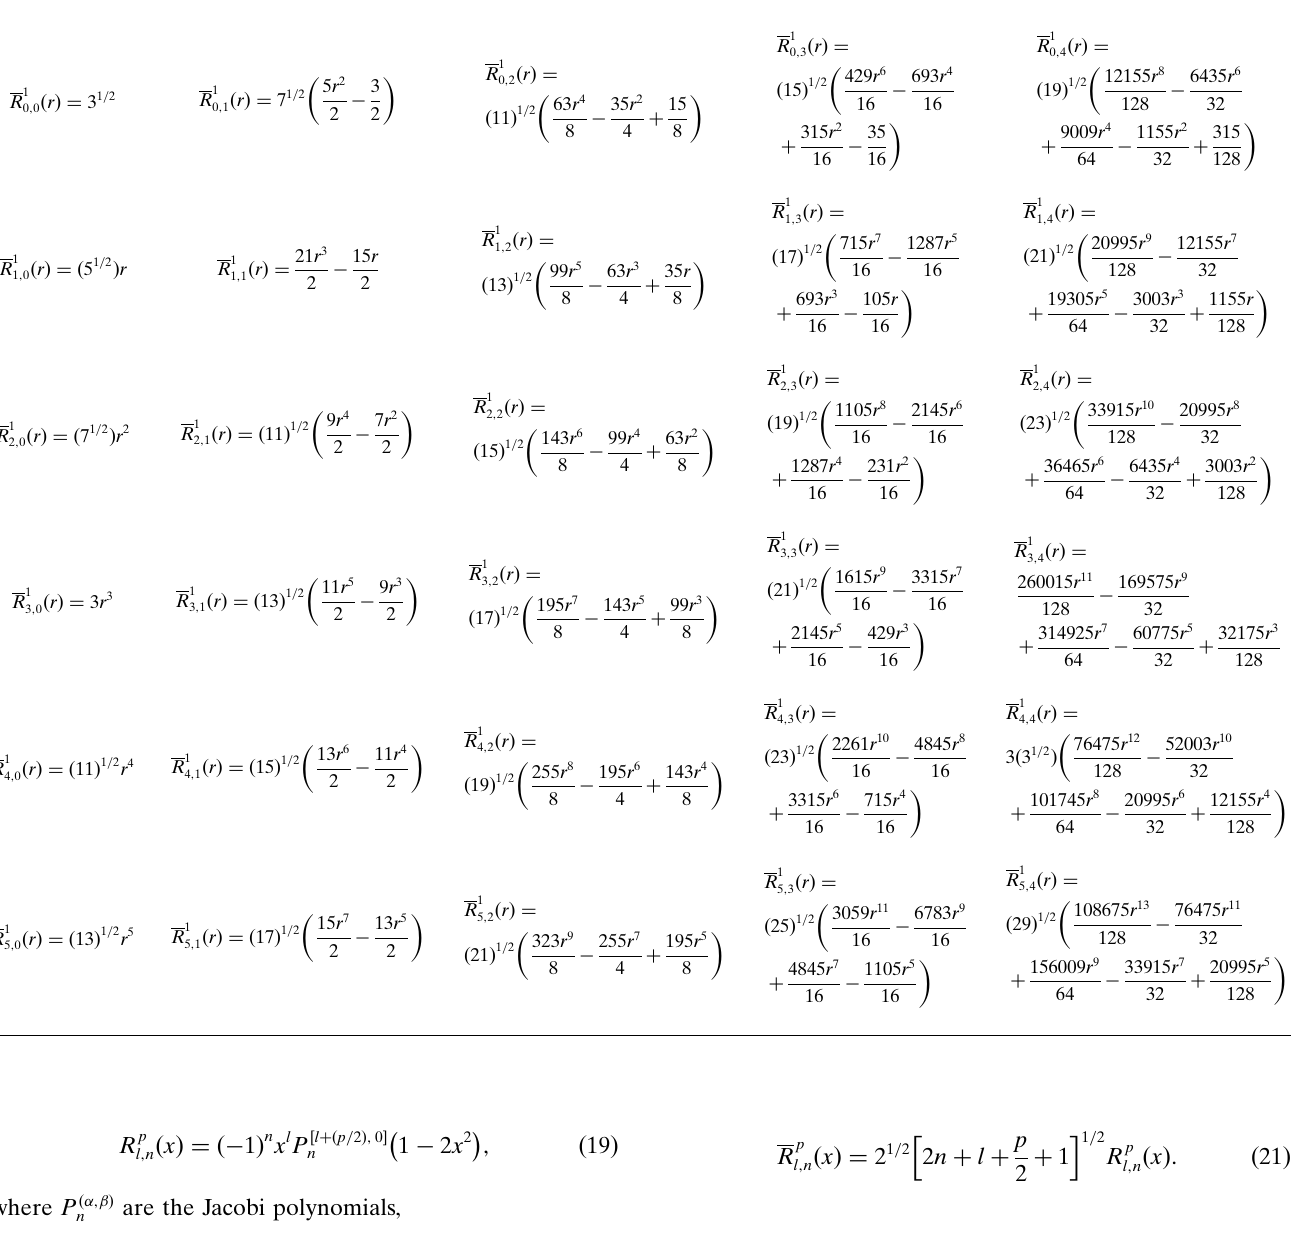
Table 2 Generalized and normalized radial Zernike